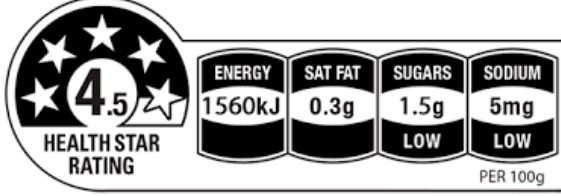
Figure A7. Health Star Rating (Australia and New Zealand) attributes a summary score between 0.5 and five stars, from the poorest to best nutrient profile. Using food group-specific conversion keys, the star rating is based on a nutritional score that assigns good and bad points for qualifying and disqualifying nutrients per 100 g. It may be complemented with quantitative energy and nutrient content information, per 100 g, 100 mL, or pack. Directiveness: Food-Directive; Scope: All